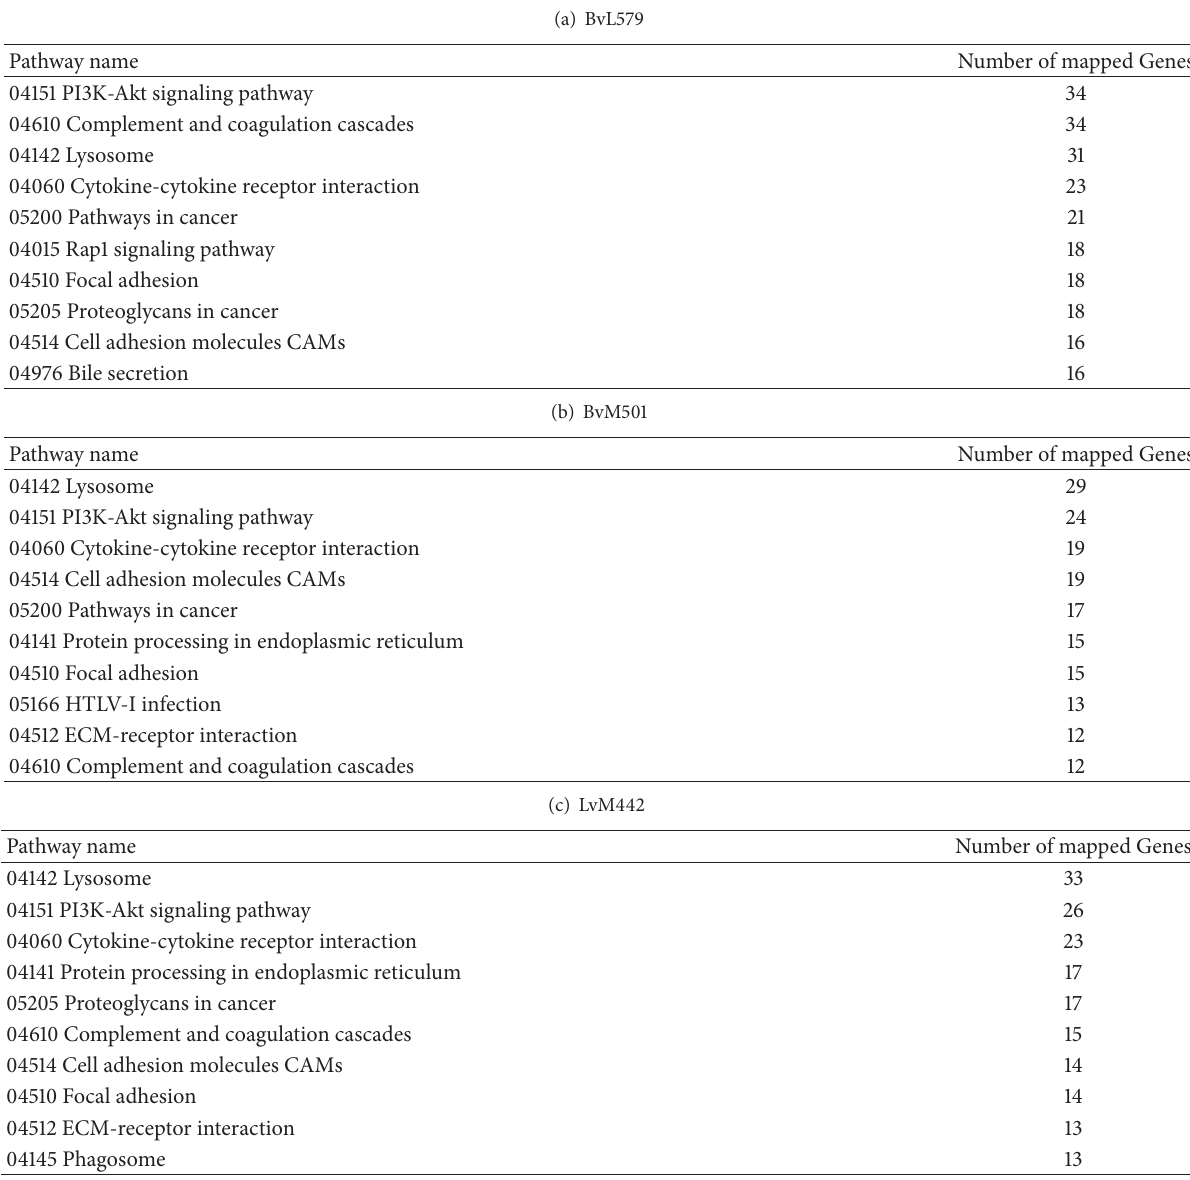
Table 3: Top 10 KEGG pathways for DEGGs in each category. (a) BvL579, (b) BvM501, and (c)